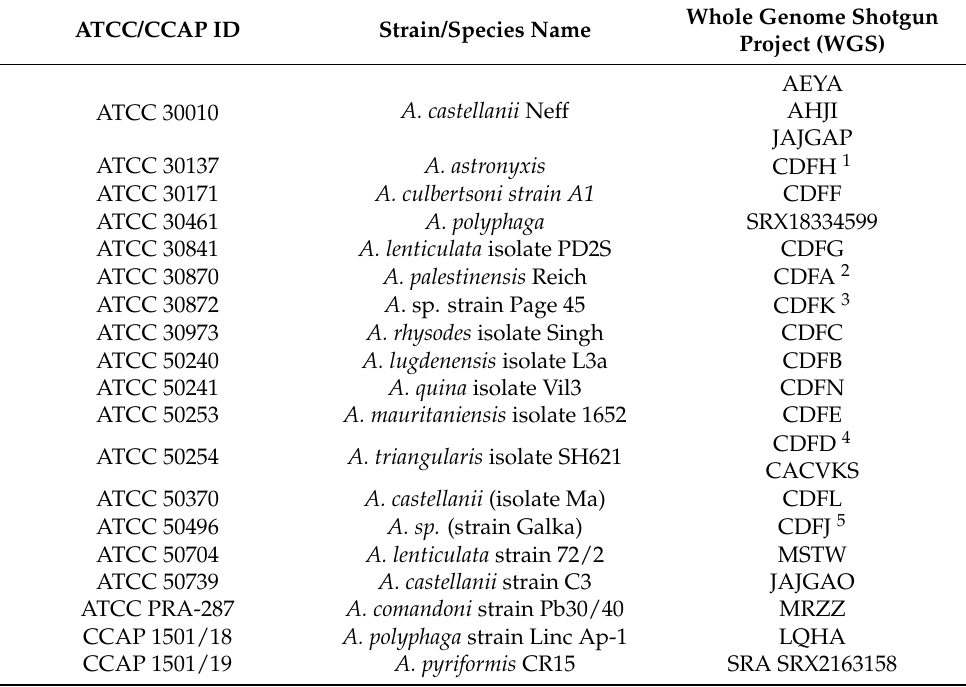
Table 2. Culture center strains that have been studied in genomic